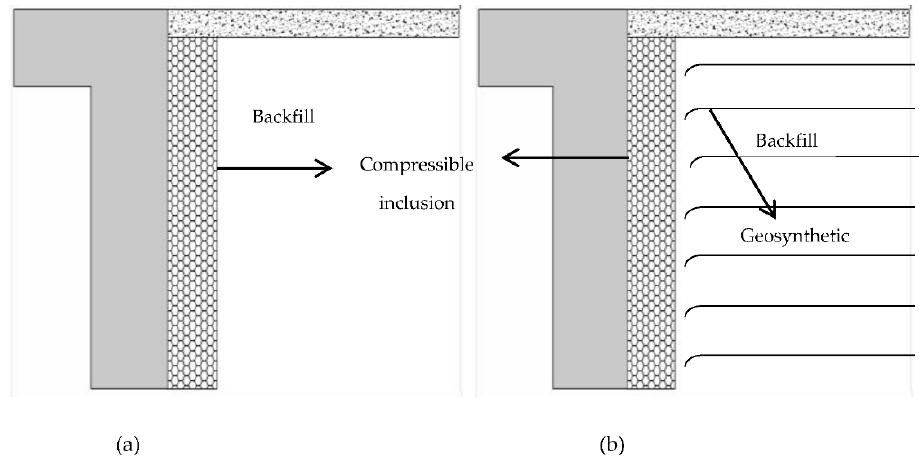
Figure 4. ( a ) partial isolation technique; ( b ) full isolation